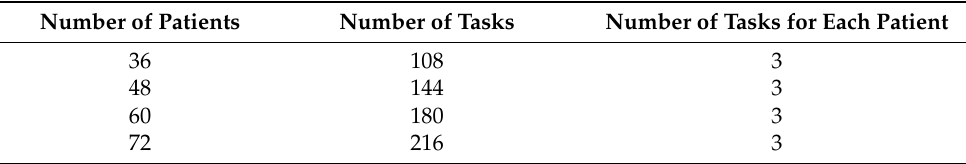
Table 6. Number of tasks when increasing the number of patients. Number of Patients Number of